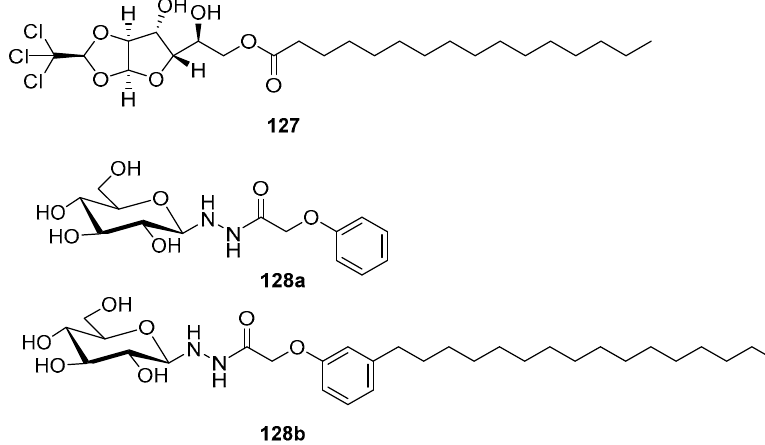
Figure 77. Gelators for antibacterial and wound healing applications [139–141].